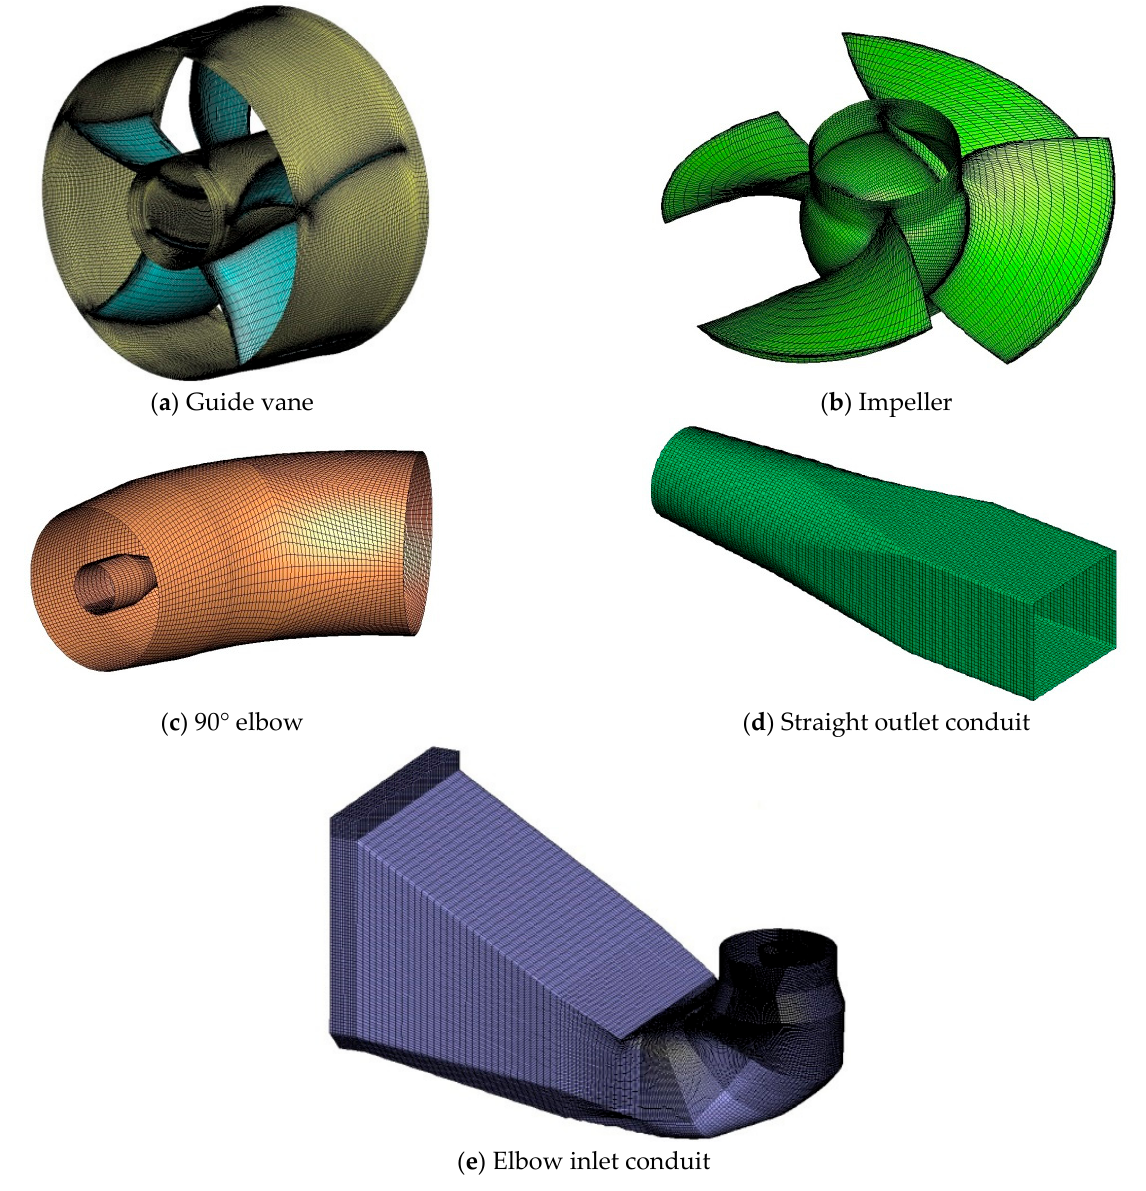
Figure 4. Grid diagram of the flow components of the axial-flow pump device. Table 1. Grid y + value of each flow component of the axial-flow pump